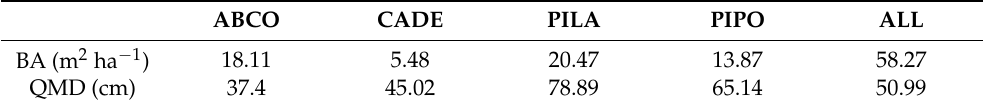
Table 1. Average basal area and quadratic mean diameter of the four main species studied and for all species combined. The “All” column total for basal area is slightly higher than the sum of the four main species due to small amounts of Jeffrey pine ( Pinus jeffreyi ) and/or red fir ( Abies magnifica ) in the sample